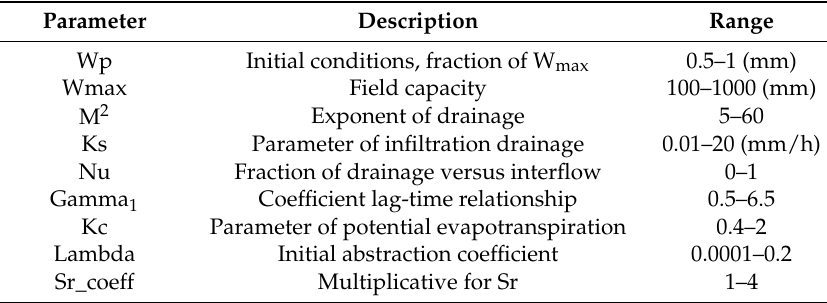
Table 3. MILc model parameters.